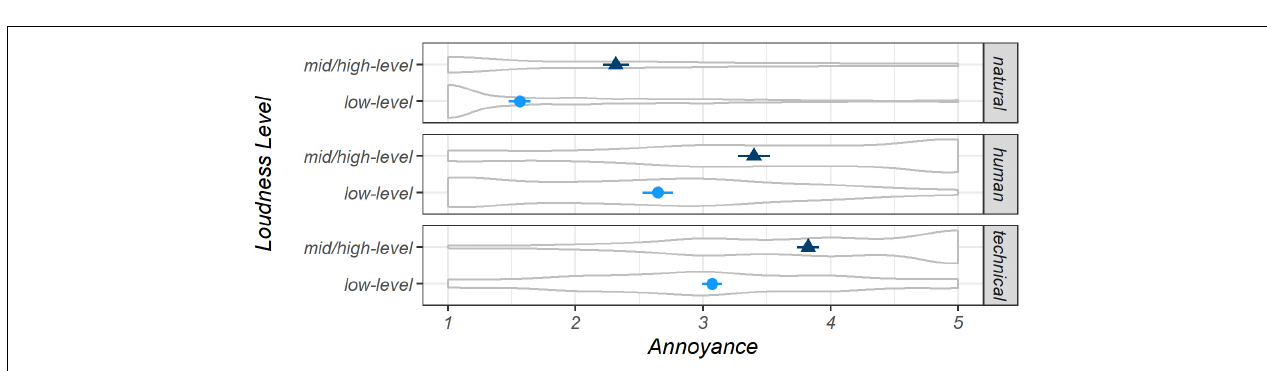
FIGURE 1 | Progression of the coefficients as a function of the tuning parameter λ during the shrinking process. The colored lines show predictors that don’t get eliminated until the optimal λ (vertical dotted line) is reached. Dummy variables that constitute one factor variable share the same color. Most coefficients follow the expected decreasing trend while some (see light green curve) show a completely unexpected and sometimes even strongly transient progression which can be considered as regularization artifacts.